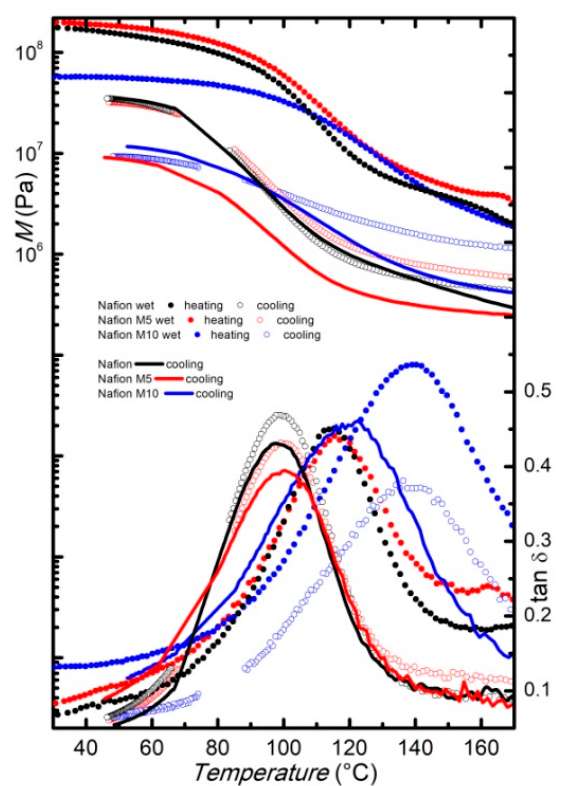
Figure 4. Modulus and elastic energy dissipation of pure Nafion (black) and composite membranes M5 (red) and M10 (blue) in the wet state, measured at f = 1 Hz, on heating (full dots) and subsequent cooling (open dots). Dry membranes measured at f = 1 Hz, on cooling (lines), are also reported for comparison.